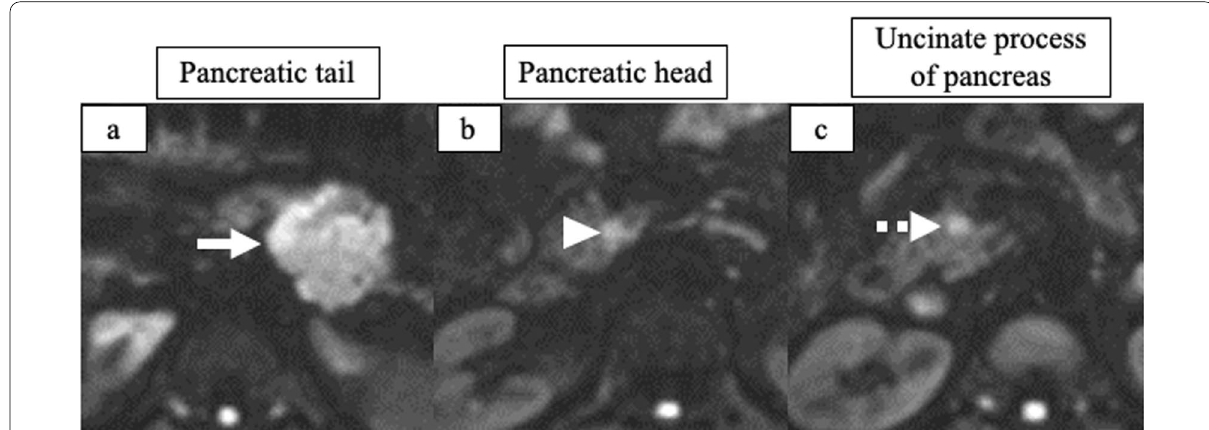
Fig. 2 MRI diffusion-weighted imaging. a The tumor located in the pancreatic tail is seen (white arrow). b The tumor located in the pancreatic head is seen (white arrowhead). c The tumor located in the uncinate process of the pancreas is seen (dotted white arrow). MRI magnetic resonance